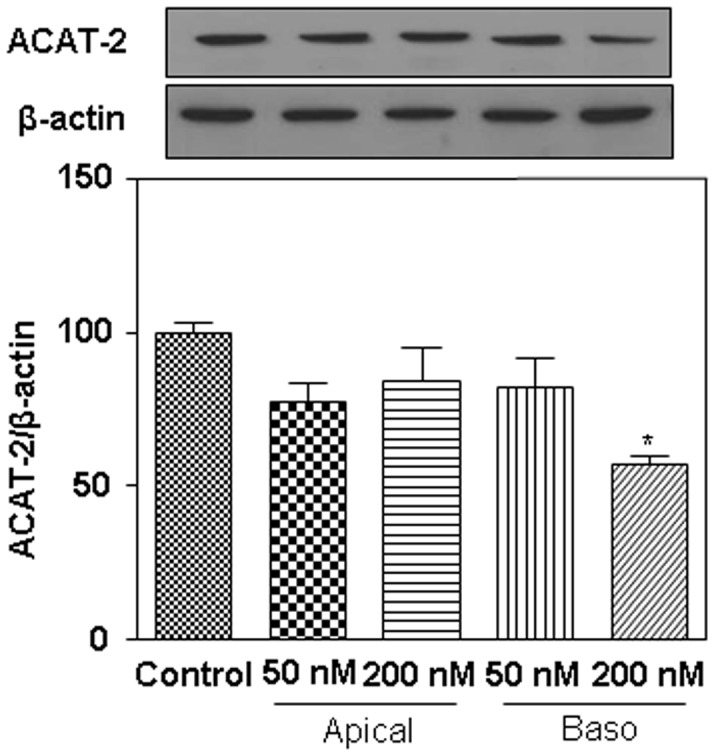
Effects of the administration of PYY (1–36) to the apical or basolateral medium on the protein expression of ACAT-2.Caco-2/15 cell line was cultured for 24 h in MEM described in Figure 2. Western blot was used to analyze the protein expression of ACAT-2. Values are means ± SD for n = 3 separate experiments in each group and are reported as percent. *P<0.01 vs. controls.